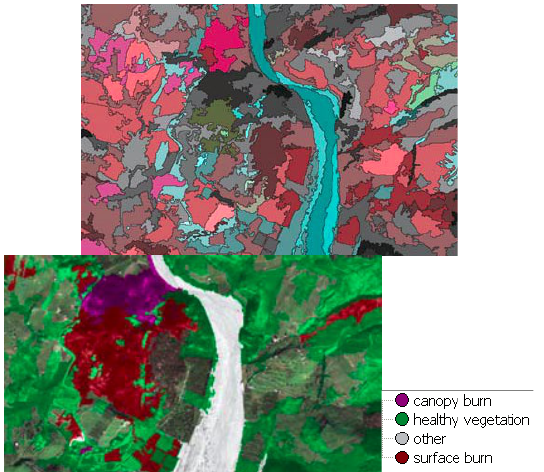
Figure 13 and Figure 14. Ikonos image: third level (coarse) of segmentation; Ikonos: classification Overall Accuracy 84.6320%